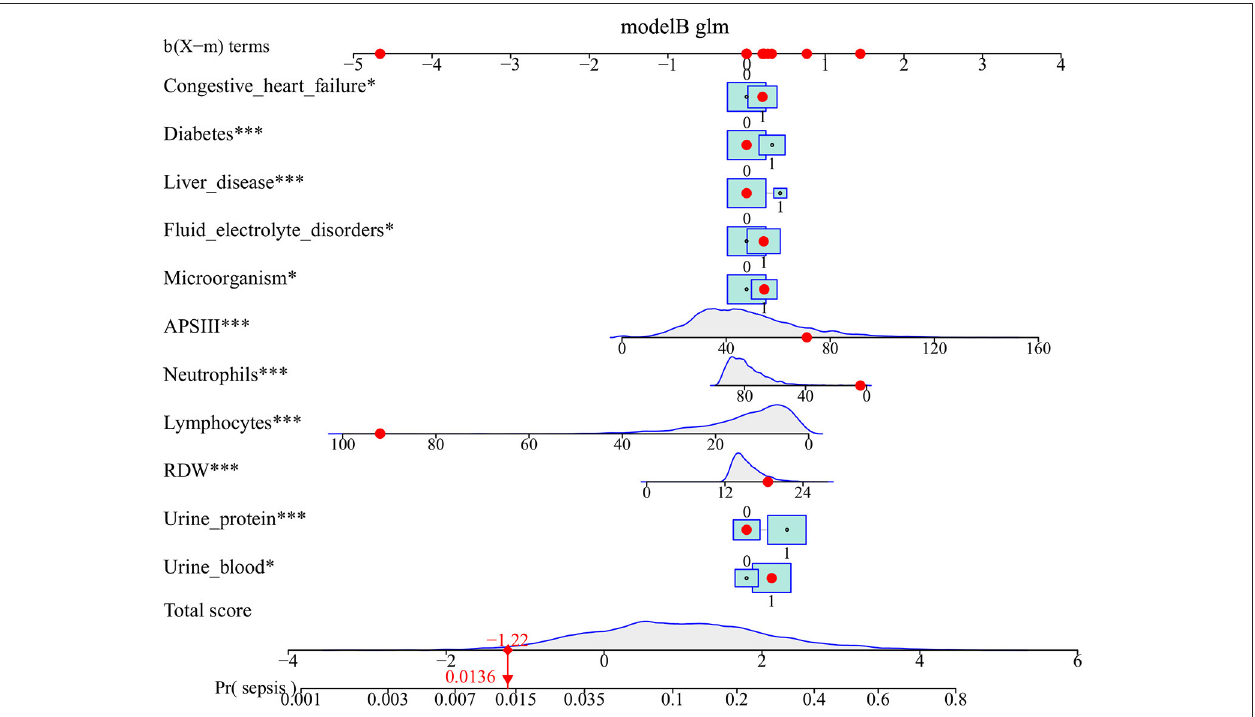
FIGURE 1 | Nomogram predicts the probability of sepsis in patients with urinary tract infection. When using the nomogram, drawing a vertical line from each variable upward to the terms and then recording the corresponding points. The point of each variable was then summed up to obtain a total score that corresponds to a predicted probability of sepsis at the bottom of the nomogram. The red dots represent the indicators of a patient in our study population and the corresponding probability of sepsis. For comorbidities, 0 means that the patient does not have this comorbiditiy, 1 means that the patient has. For laboratory test results, 0 means negative, and 1 means positive. * p < 0.05, and *** p < 0.001 in the multivariate logistic analysis.